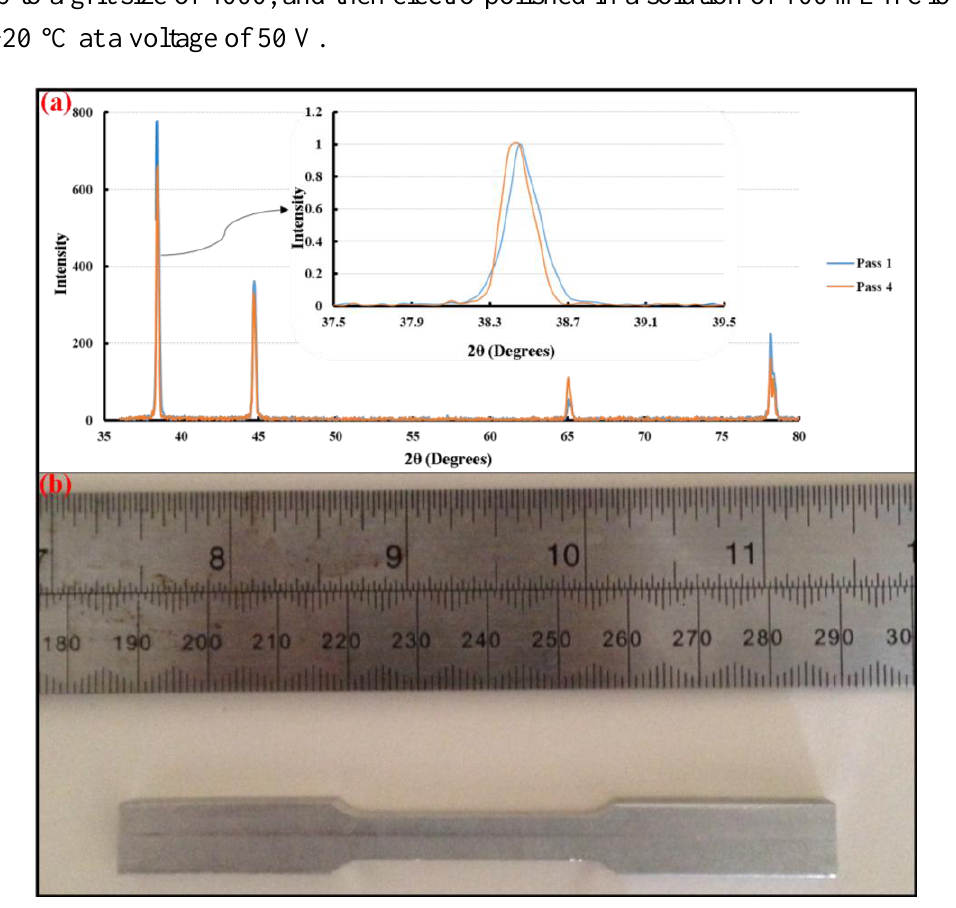
Figure 3. ( a ) The XRD pattern of the CP aluminum after the first and fourth passes of the ECFE process and ( b ) the prepared tensile testing sample of a CP aluminum